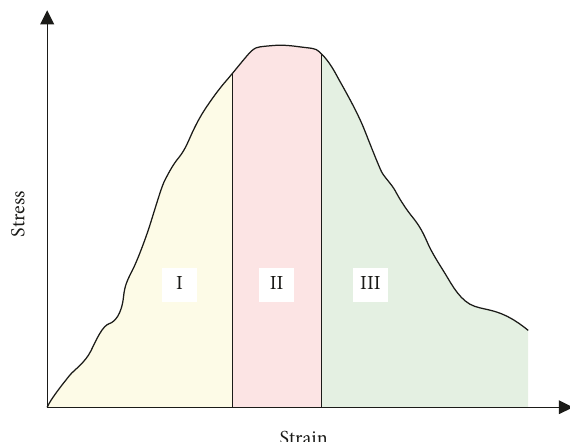
Figure 14: Three stages of dynamic failure of foam